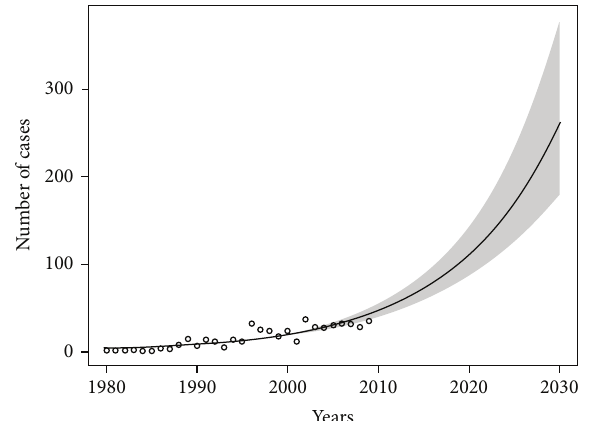
Figure 1: The forecast of increasing incidence of asbestos-related lung cancer in Poland until 2030. Significance level of model: 𝑃 < 0.01